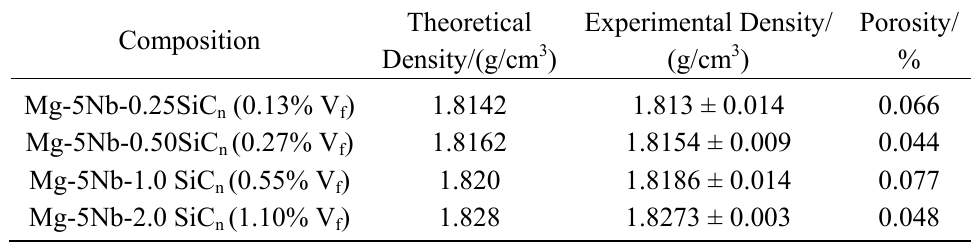
Table 1. Results of Density and Porosity Measurements in Mg-5Nb-SiC